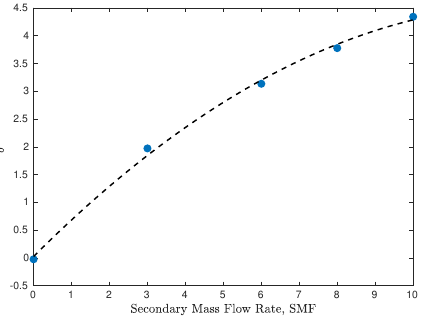
Figure 14. Diagram of pitch thrust-vector angle δ against the secondary mass-flow rate, SMF .